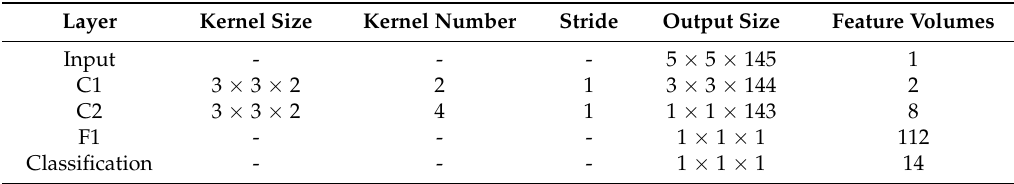
Table 6. Architecture of 3D-CNN in Botswana